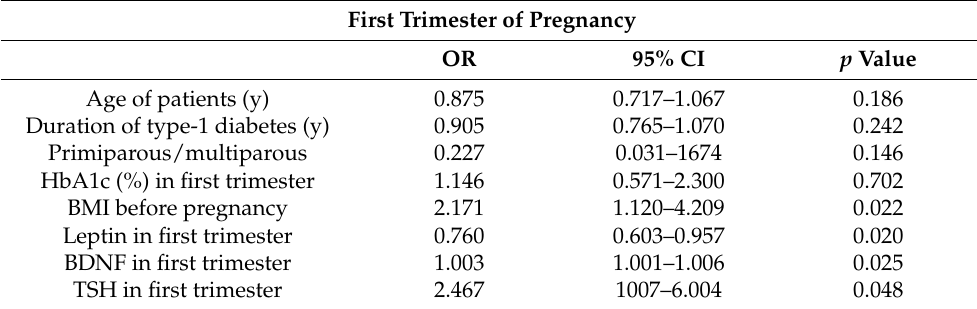
Table 5. Odds of the overweight neonate for BMI, HbA1c, leptin, and BDNF in the first trimesters of